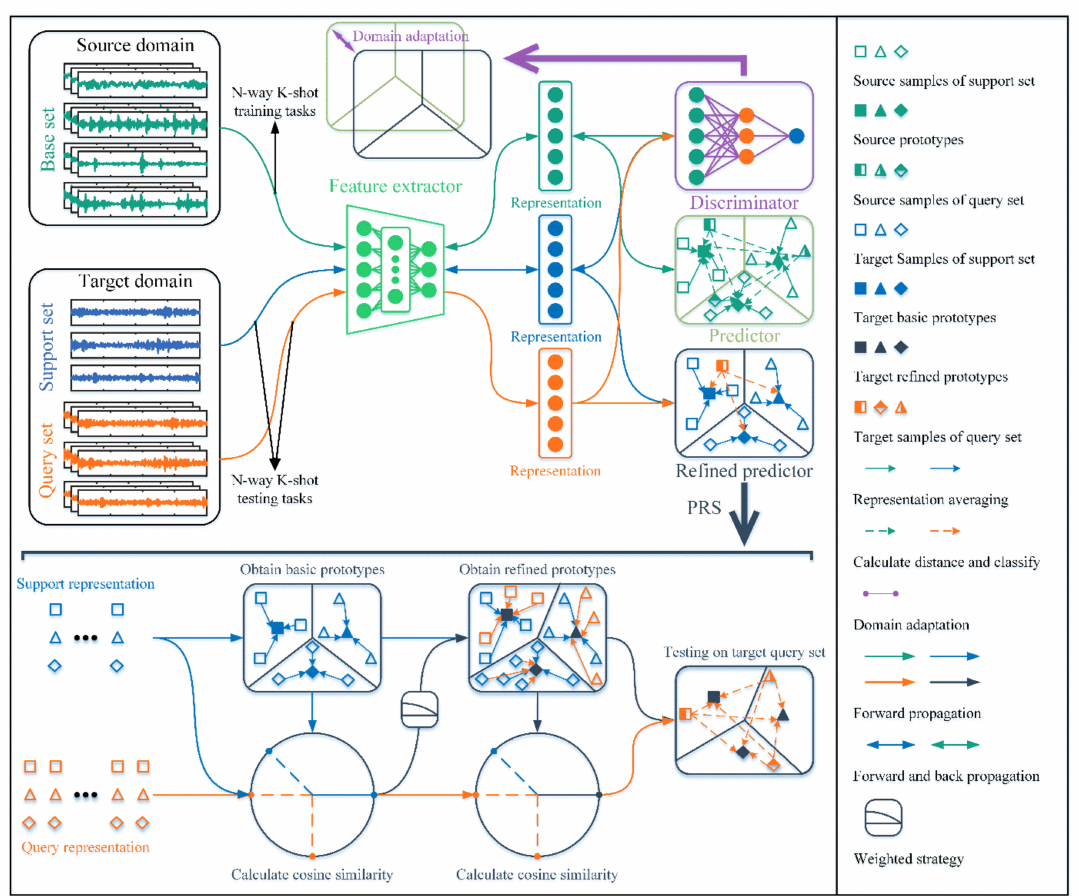
Figure 4. The proposed